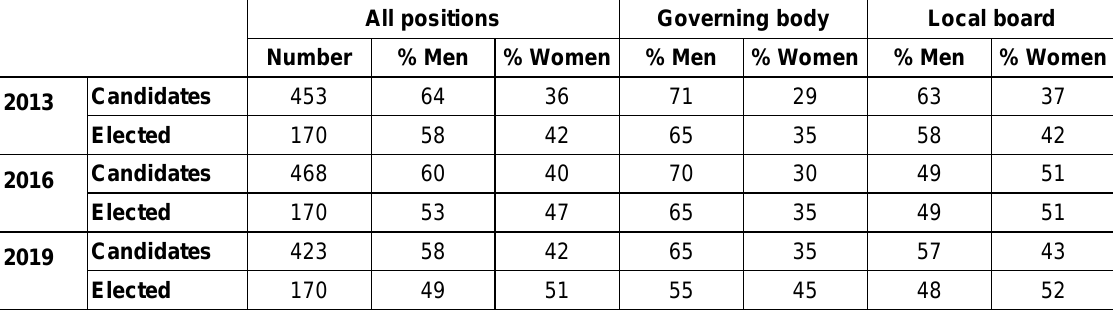
Table 3: Auckland Council candidates and elected members by gender